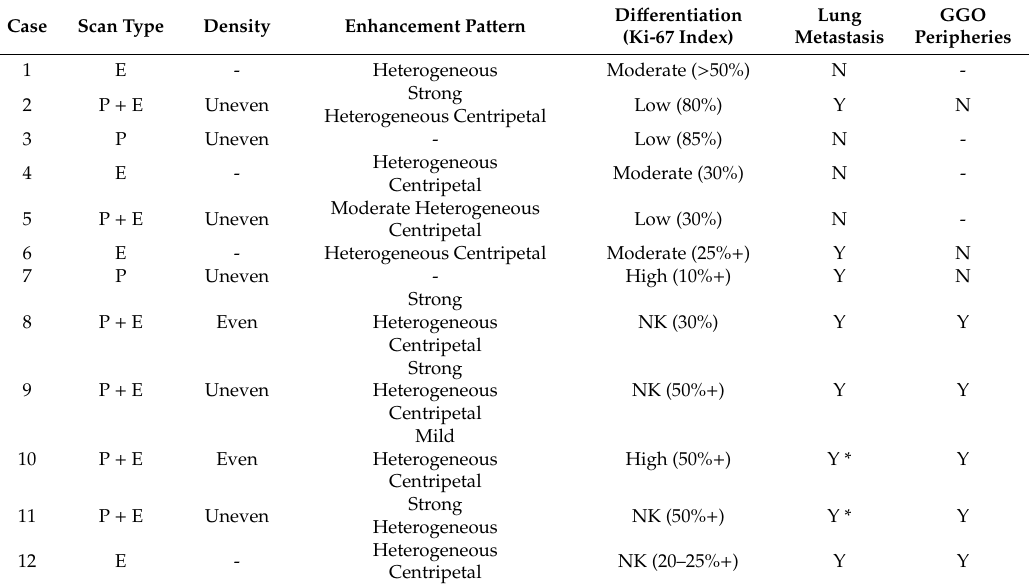
Table 2. CT features of primary cardiac angiosarcoma.